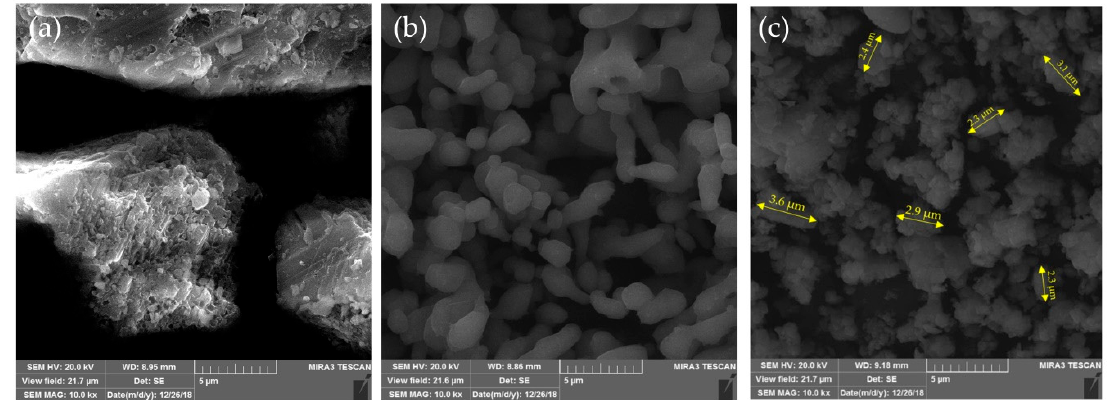
Figure 5. Scanning electron microscope (SEM) micrographs of raw materials and products during catalyst synthesis: (a) ES-R, (b) ES-900, and (c) ES-HC-600. Table 1. Texture properties obtained by Hg-porosimetry and N 2 -physisorption.